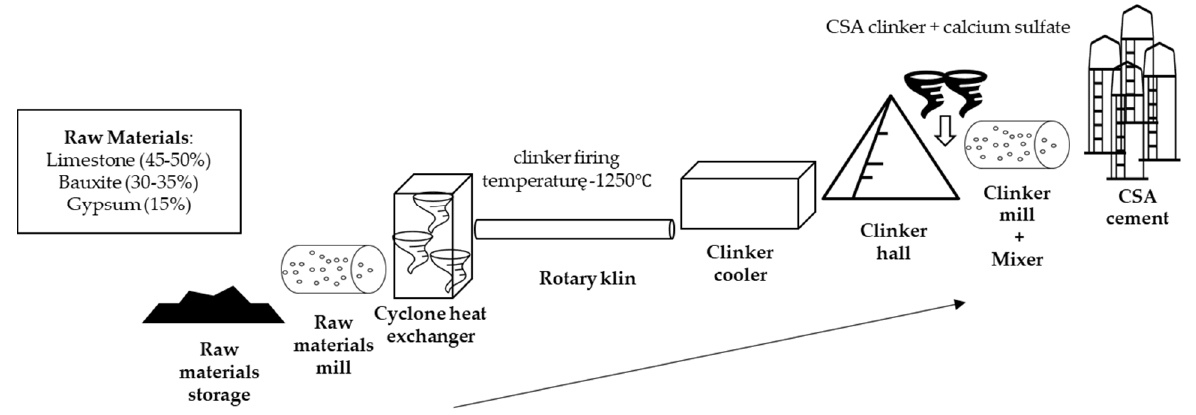
Figure 7. Clinker and CSA production scheme.